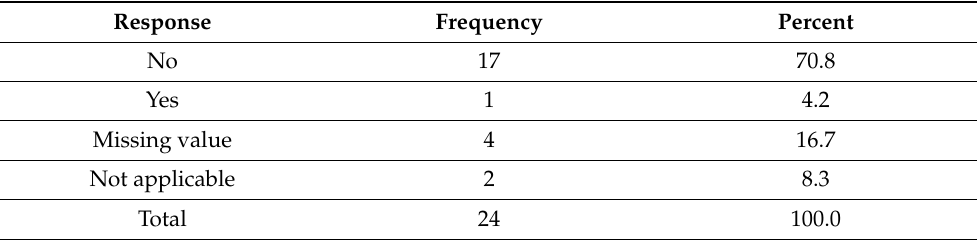
Table 3. Showing Whether Previous Disclosures Were Made to the